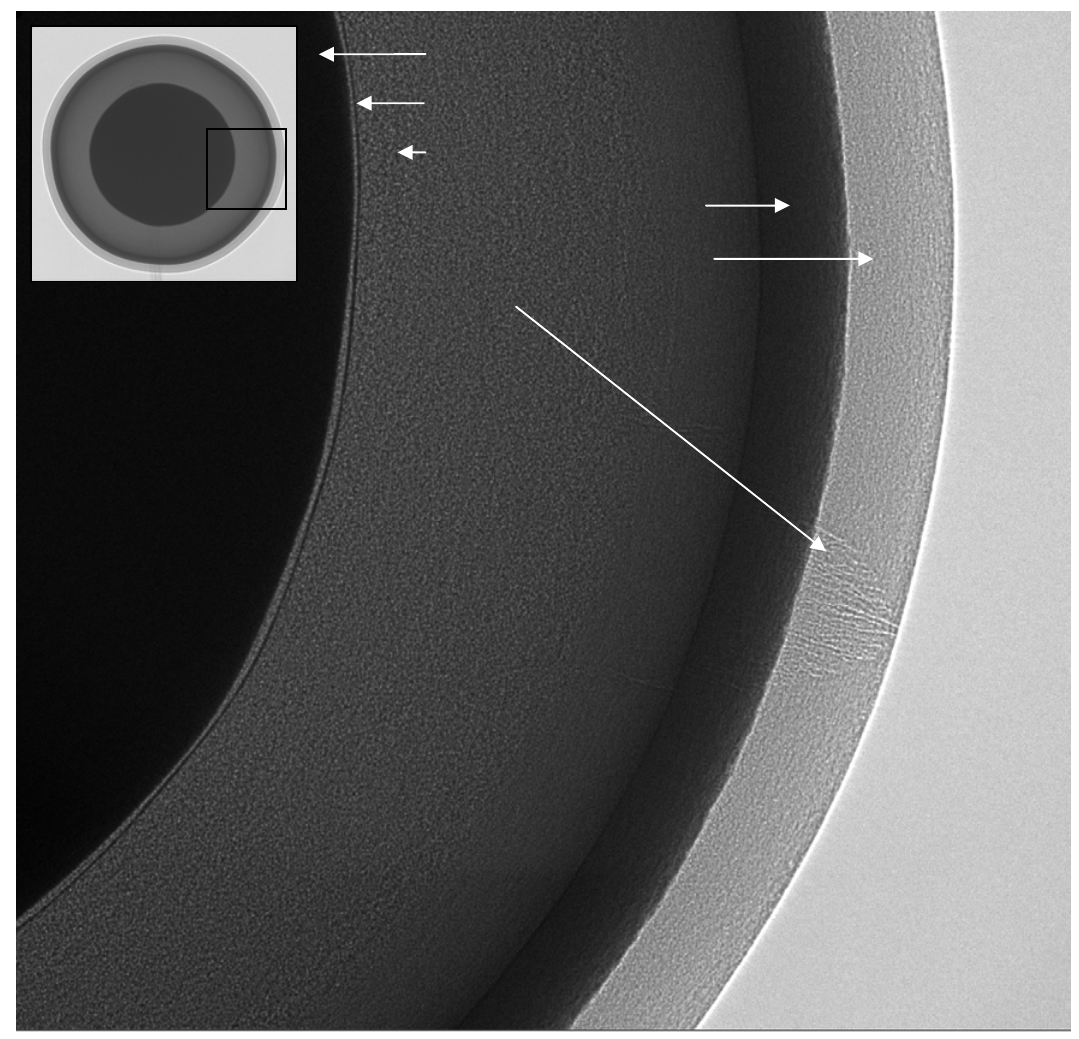
Figure 7. 2D Phase-contrast X-ray image of a fuel pellet consisting of layers of pyrolitic carbon and silicon carbide on a zirconia core. In the main image a crack can be seen, highlighted by phase-contrast, in the outer pyrolitic carbon layer. The inset is a lower magnification image providing an overview of the whole sample, approximately 800 μ m in